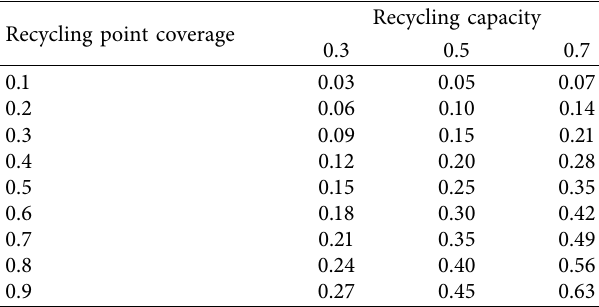
Table 3: Offline recycler enthusiasm analysis